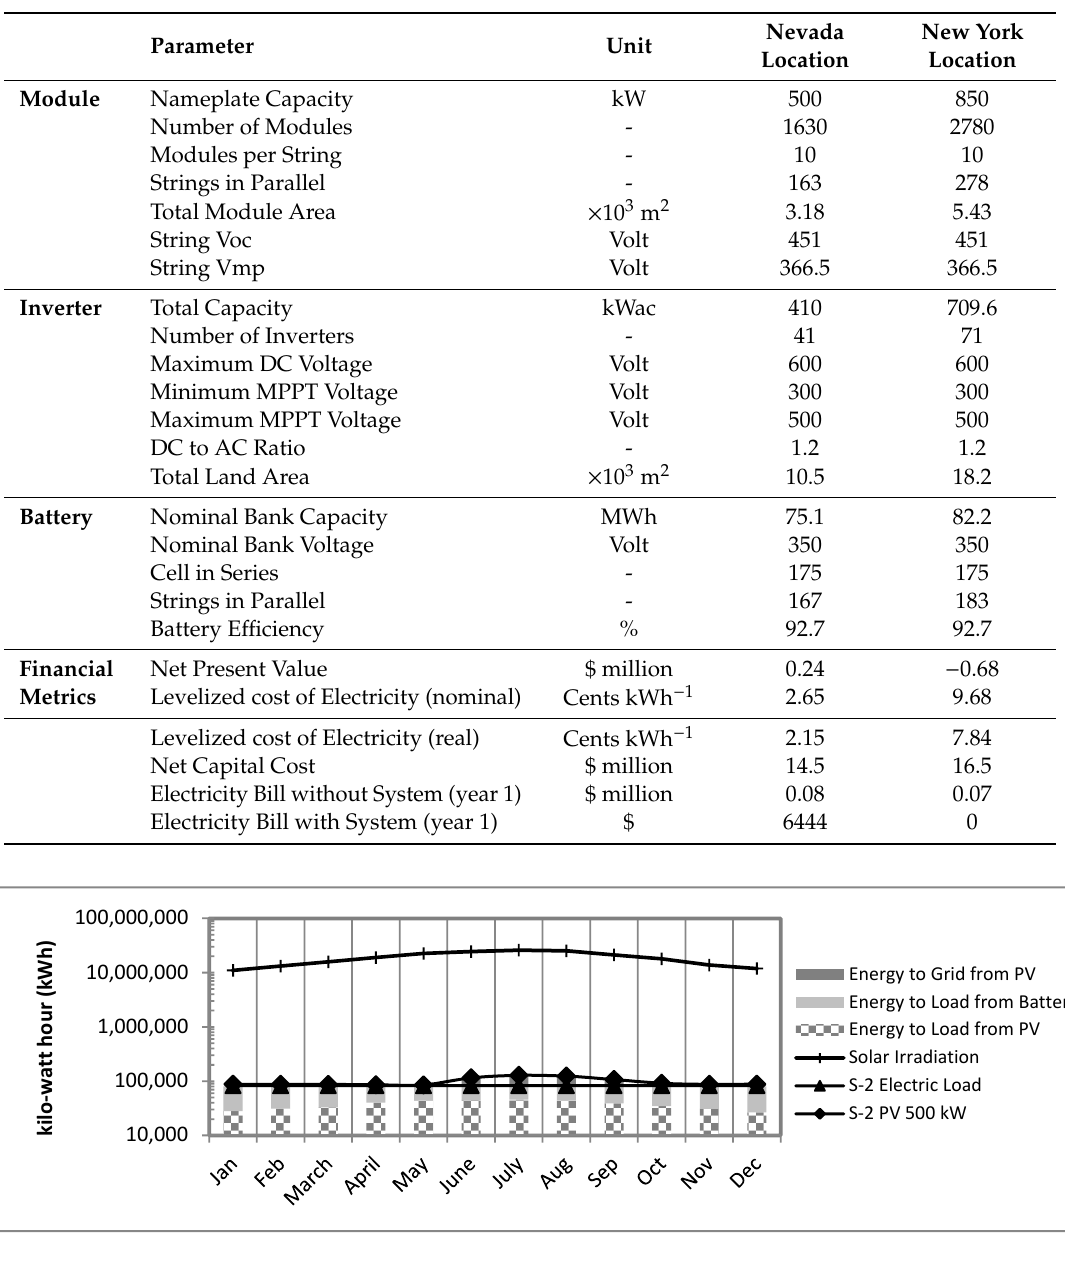
Table 7. Results for technical and financial analysis of solar PV system using the system advisor model for scenario S-2 (analysis for energy consumption of water treatment plant excluding distribution pumps) for locations of Nevada and New York.